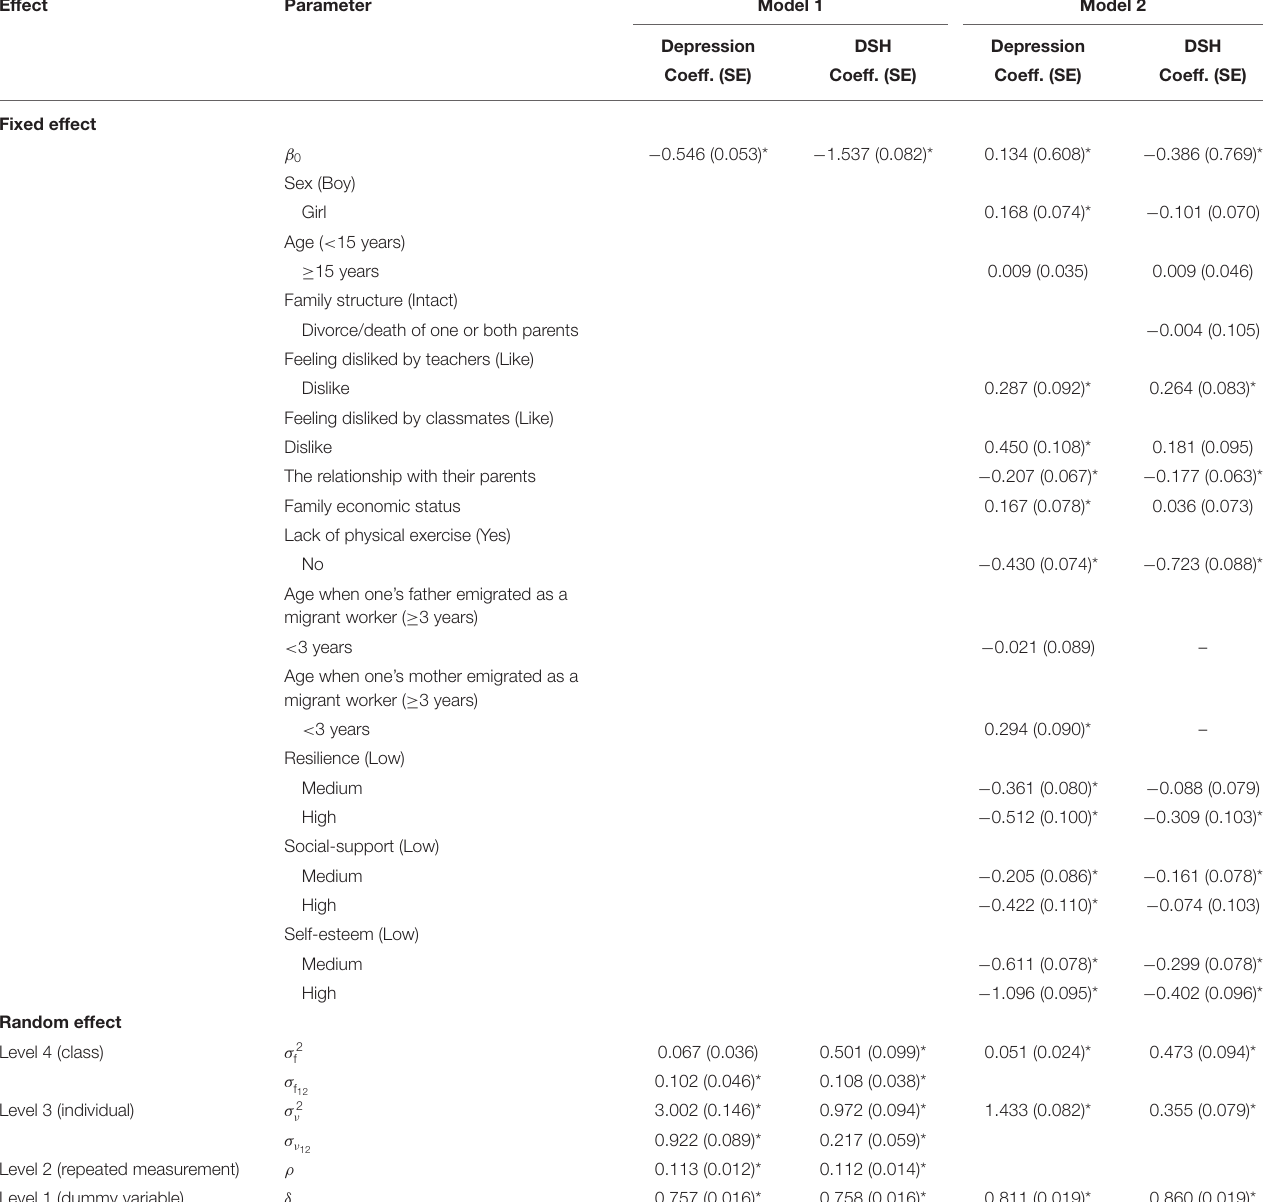
TABLE 3 | Bivariate four-level logistic regression model of depression and